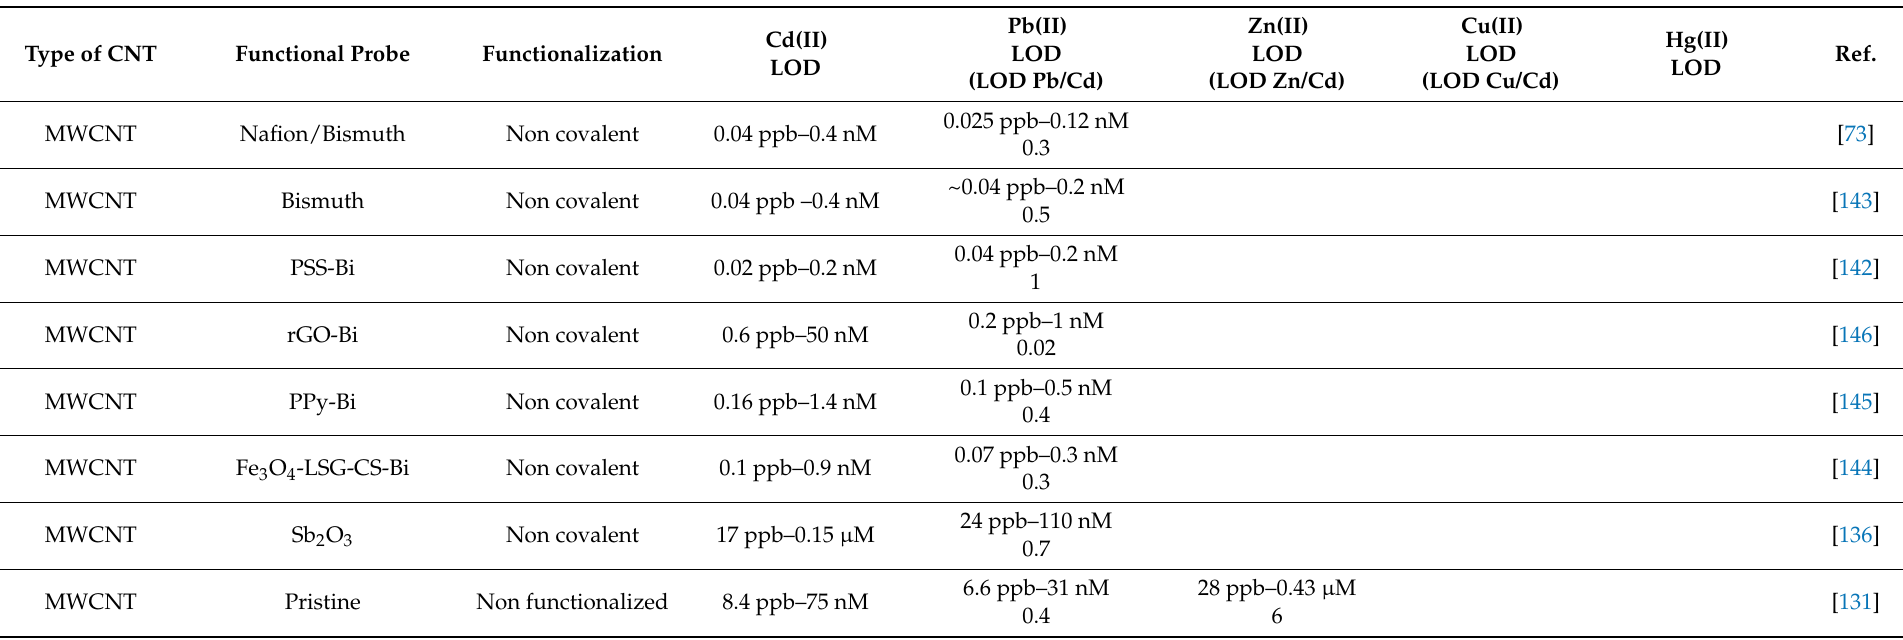
Table 10. Comparison of the performances of sensors based on multiplexed detection as a function of the target